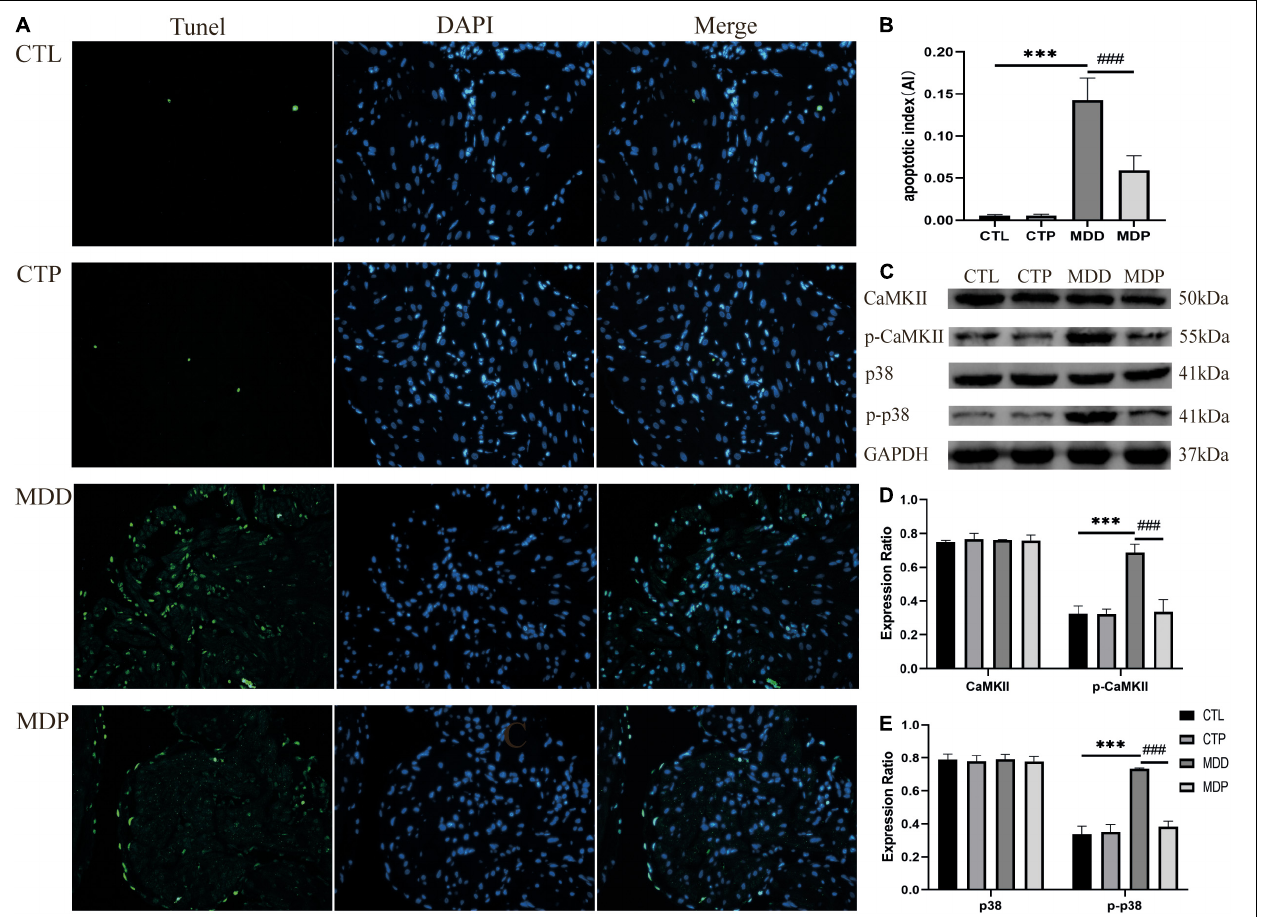
FIGURE 10 | Atrial cell apoptosis and the levels of related proteins. (A) Typical images of TUNEL staining. Apoptotic cells exhibit green fluorescence, and nuclei show blue fluorescence. (B) The apoptotic index of the four groups, n = 6 per group. (C) Immunoblotting of CaMKII, p-CaMKII, p38, and p-p38. (D,E) Quantitative analyses of CaMKII, p-CaMKII, p38, and p-p38, n = 5 per group. *** p < 0.001 vs. CTL; ### p < 0.001 vs.